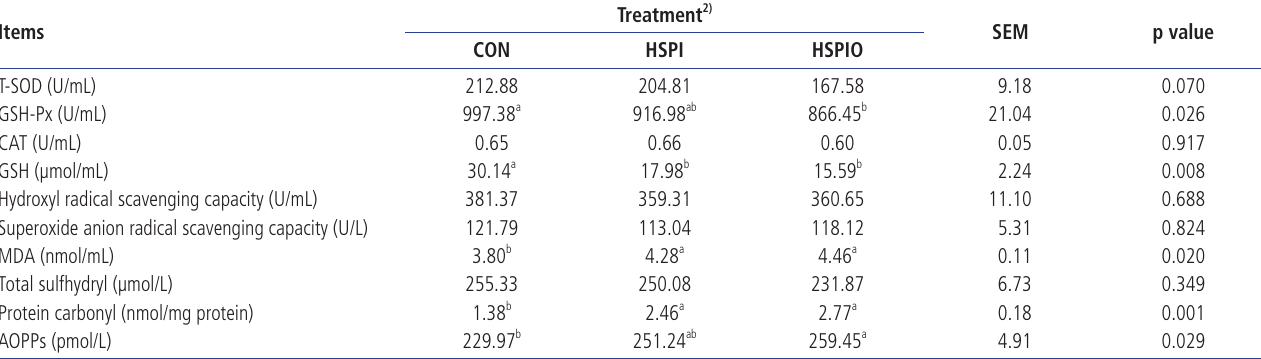
Table 5. Serum antioxidant indices and oxidation products contents of broilers fed basal diet, heat-oxidized SPI diet or heat-oxidized mixture of SPI and 2% soybean oil diet 1)